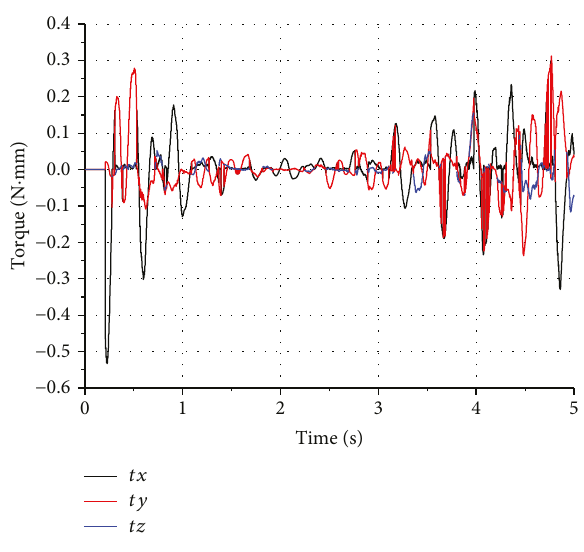
Figure 13: The pneumatic of adapter 3. Table 3: The placement data of adapters.